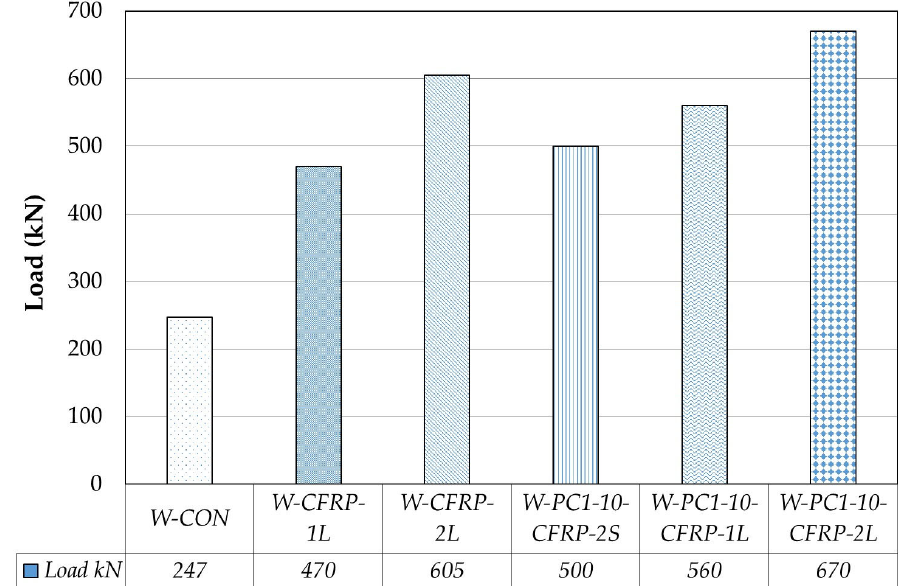
Figure 10. Comparison of ultimate load carrying capacities of CCI brick masonry walls.